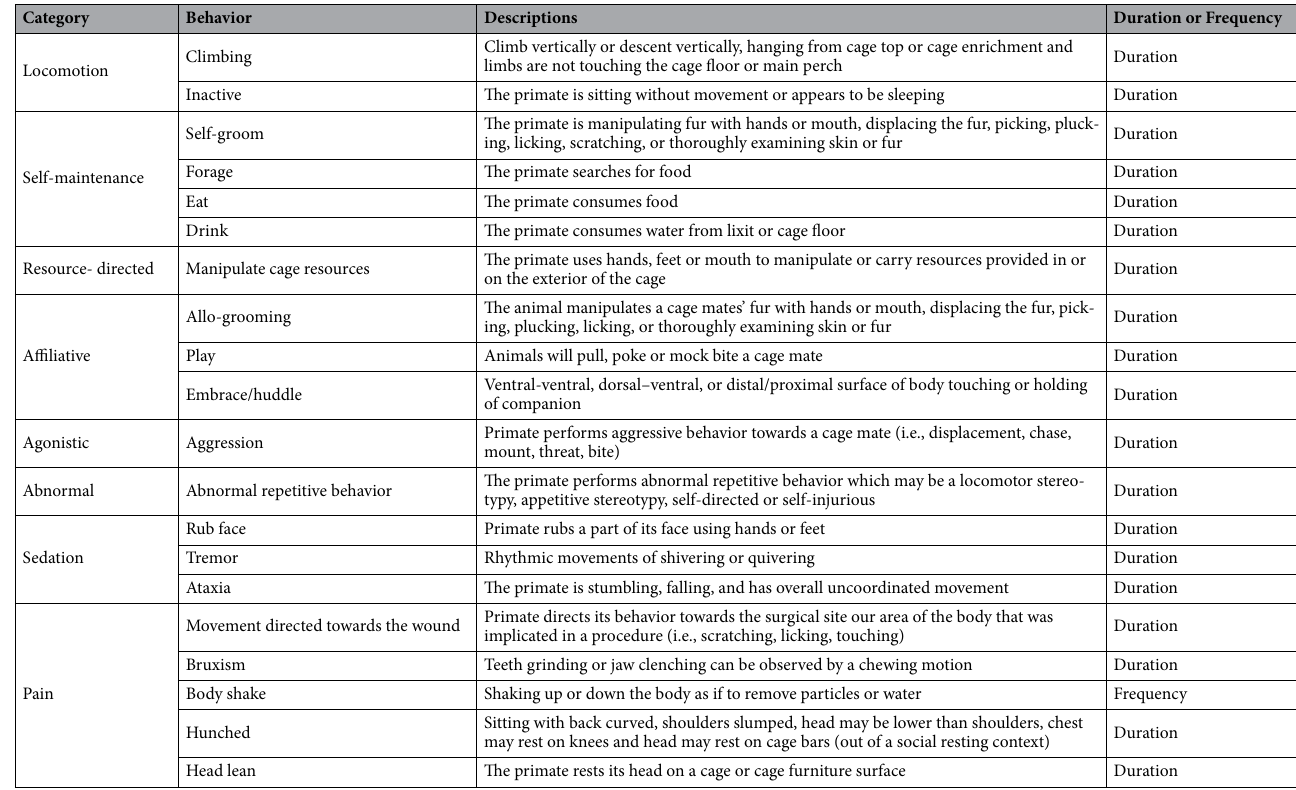
Table 2. Primate behavior ethogram (adapted from 19